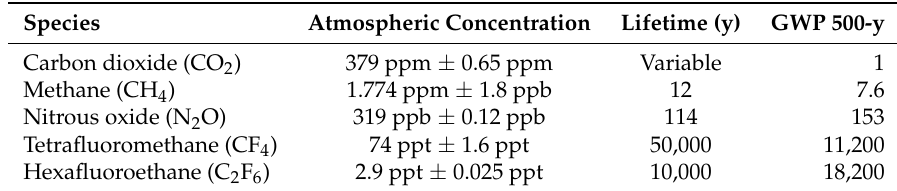
Table 1. Overview of atmospheric concentration levels, lifetimes and global warming potentials for a time period of 500 years